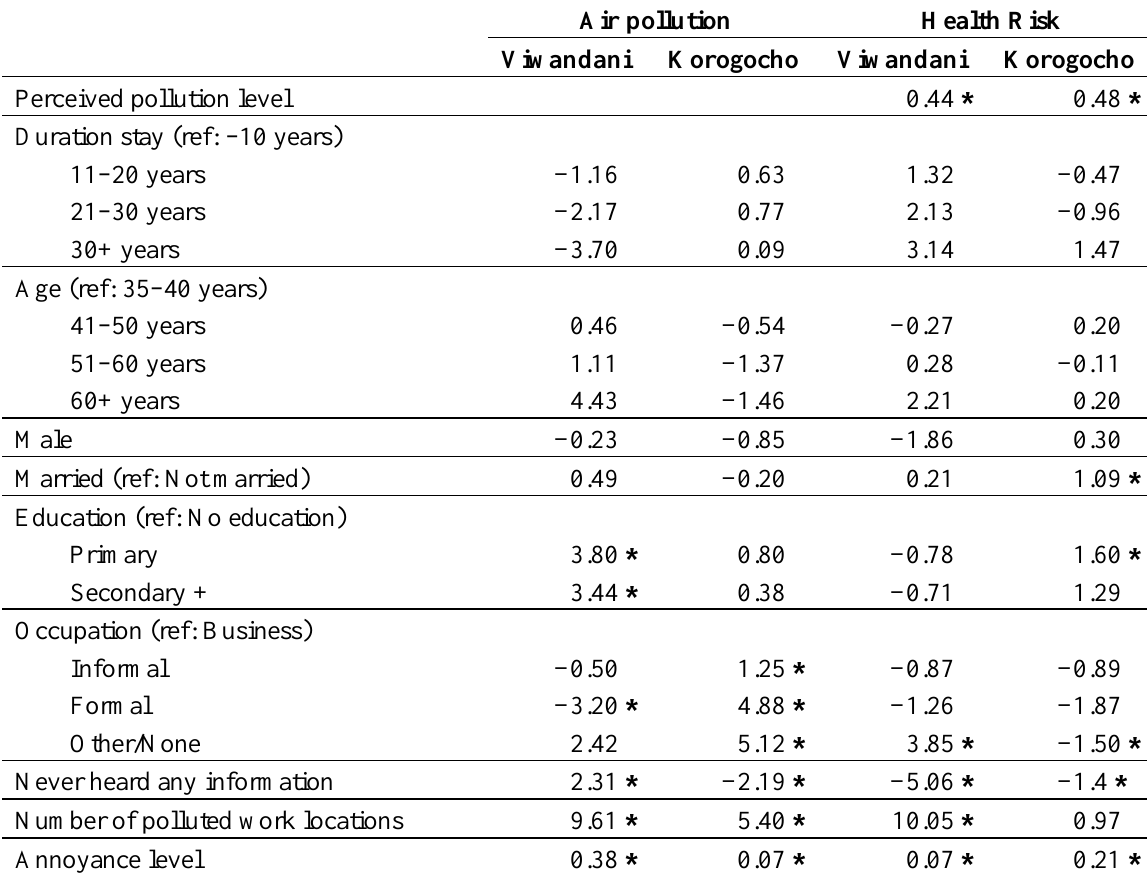
Table 5. Characteristics associated with perceived level of air pollution and related health risks. Air pollution Health